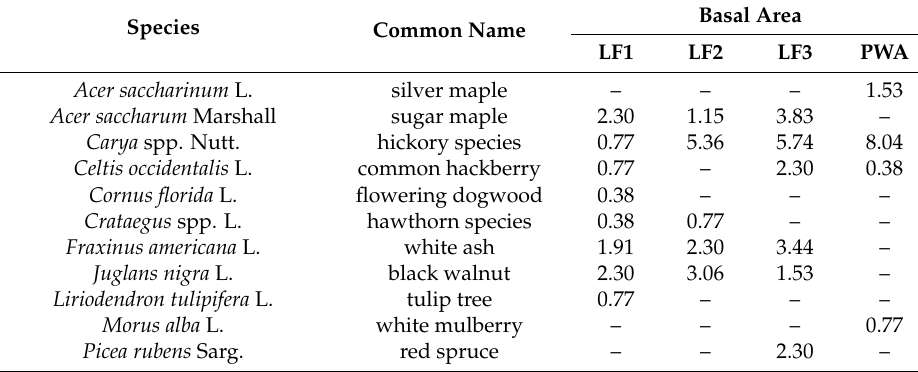
Table 1. Mean basal area (m 2 ha − 1 ) of overstory tree species at each site. Three sites were at the Richard G. Lugar Forestry Farm (LF1–3) and a fourth was at the Purdue Wildlife Area (PWA) in West Lafayette, IN. Data were collected using a variable radius plot (basal area factor = 2.296 m 2 ha − 1 ) during summer 2016 in treatment areas and winter 2016–2017 in reference